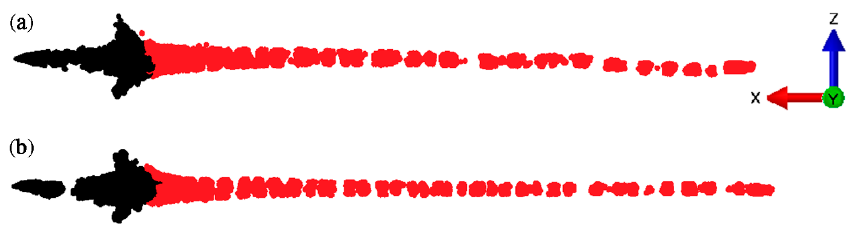
Figure 16. Qualitative comparison of the effect of the collapsing liner material on the formation of the slug and the jet. ( a ) the jet from detonation of an axial charge ; ( b ) the jet from detonation of an peripheral charge .